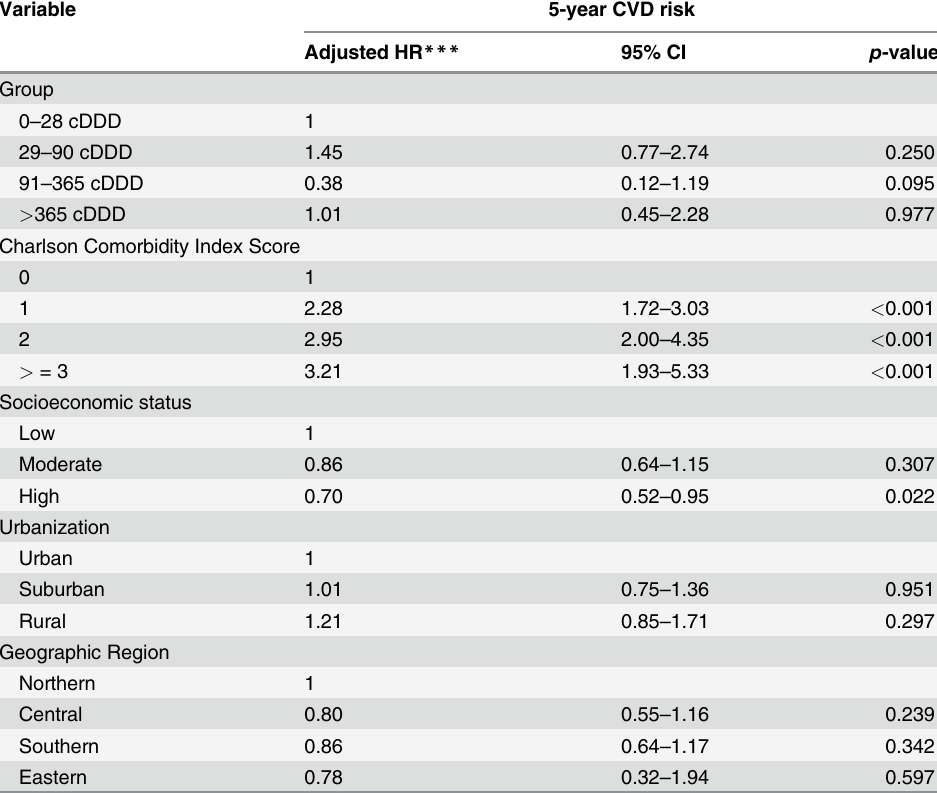
Table 3. Multivariate adjusted hazard ratios (HR) of cardiovascular diseases (CVD) among younger (younger than 65 years old) patients receiving and not receiving 5-alpha reductase inhibitors from 2003 to